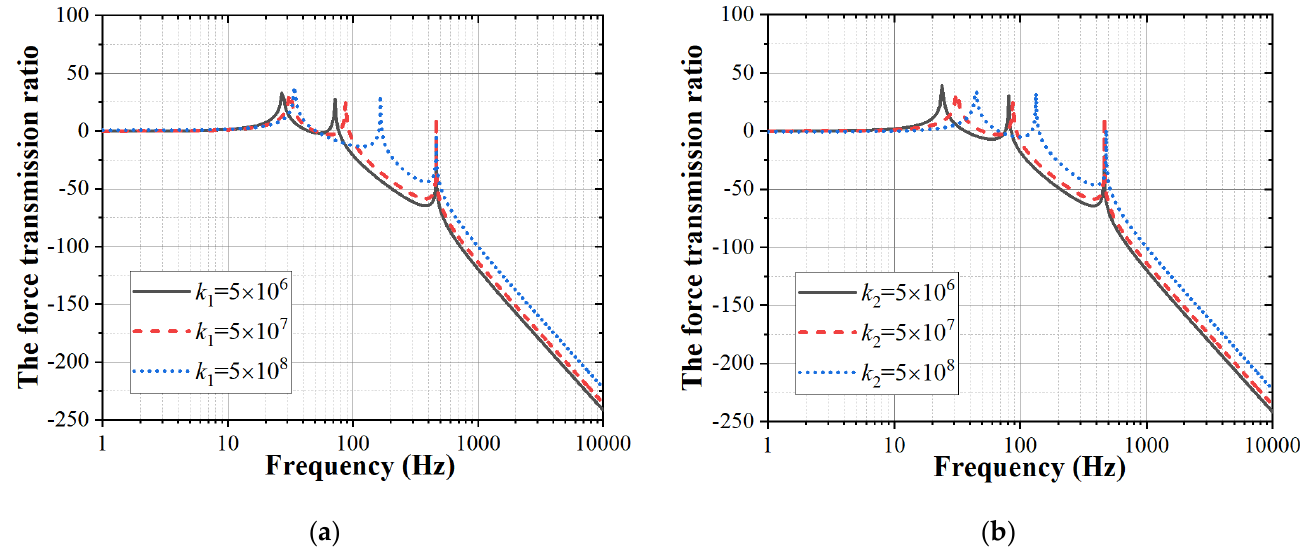
Figure 8. The force transmission ratios of the two-stage vibration isolation ( a ) with different first-order isolator stiffnesses and ( b ) with different second-order isolator stiffnesses.